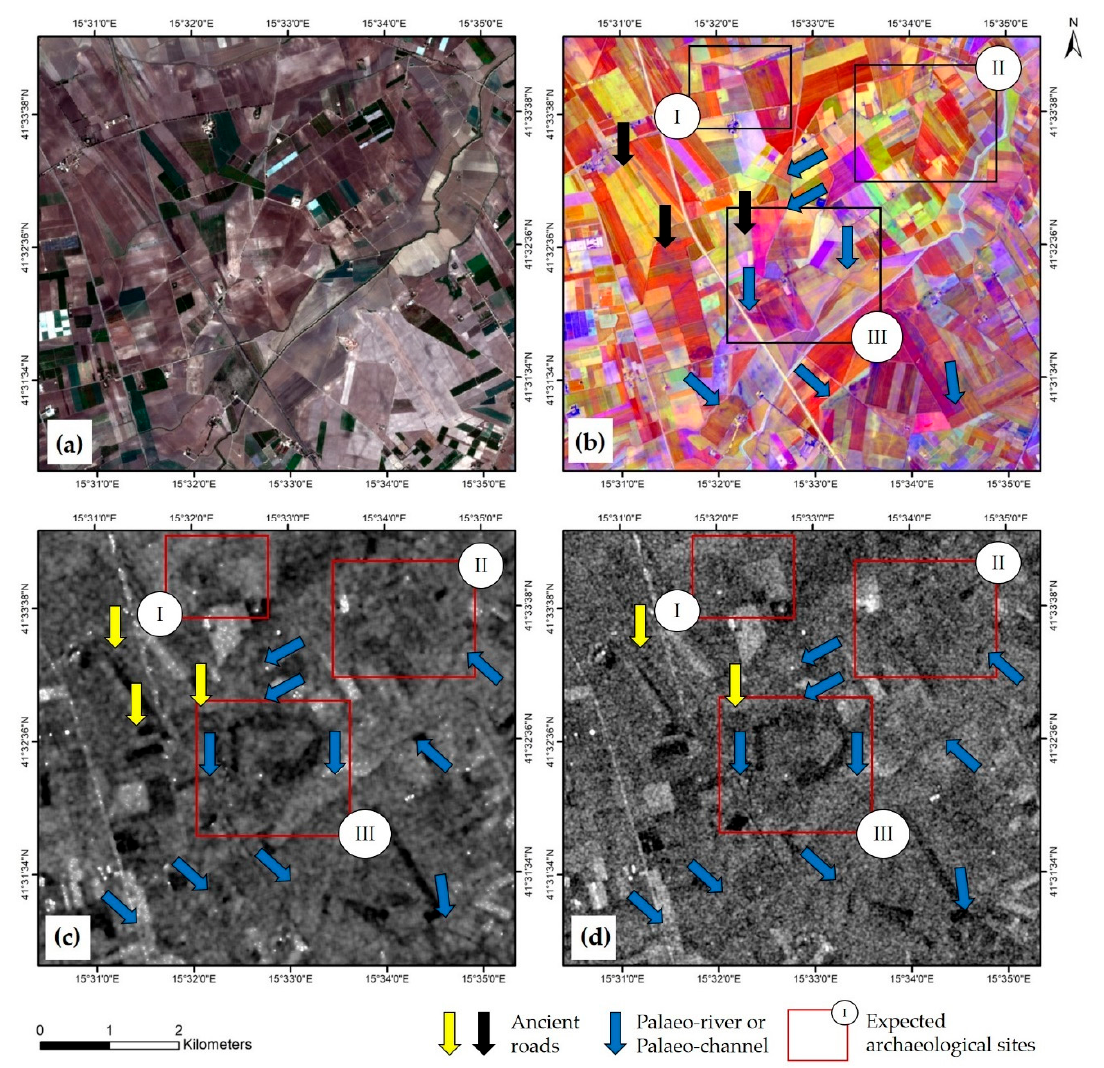
Figure 12. Landscape details observed from: ( a ) Sentinel-2 on 20 October 2019 (RGB); ( b ) PCA based on multitemporal analysis of Sentinel-2 images [58, Figure 9c]; ( c ) VH (on the left seems less in appearance) and ( d ) VV (on the right seems clearer) polarizations captured on S-1 19 October, 2019.